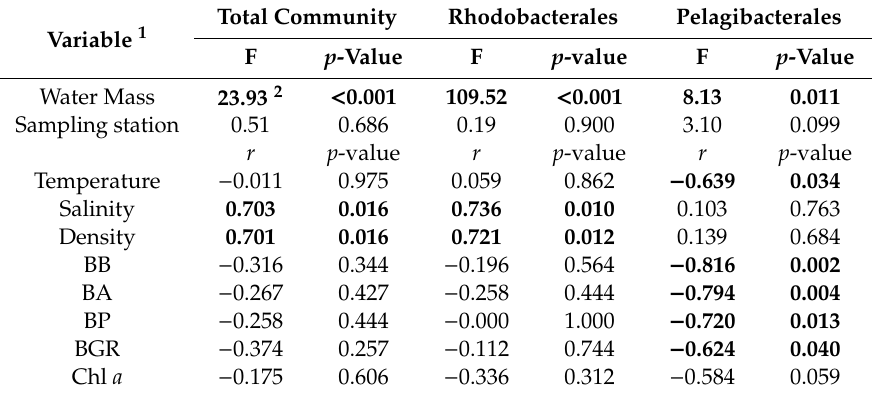
Figure 8. Relative abundance of lineages within the order Rhodobacterales. The values represent the proportions of sequences matching the indicated taxonomic groups within the total number of sequences for each sample. Table 4. Relationship between Shannon diversity ( H’ ) and environmental